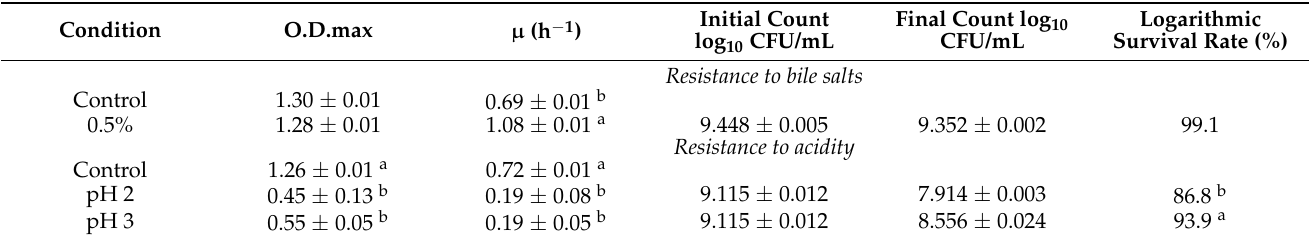
Table 2. Evaluation of tolerance to acidity and bile salts: survival rate after exposure to bile salts and pH 2 and 3 for 1